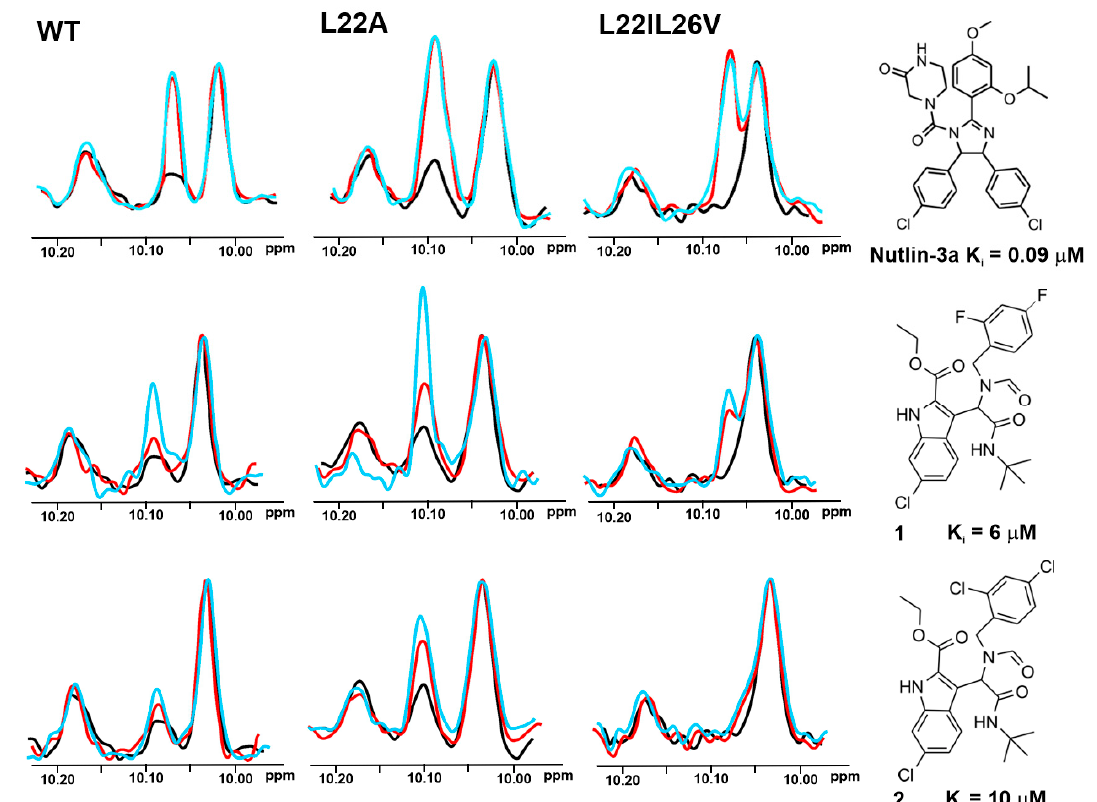
Figure 2. The 1D AIDA proton NMR spectra of the side chain N H ε protons of tryptophans for the p53 / Mdm2 complexes (p53-wt, L22A, and L22IL26V). All protein complexes (black) were treated with Nutlin-3a, compounds 1 and 2 in molar ratio: the protein to a compound 1:1 (red) and 1:2 (blue), respectively.